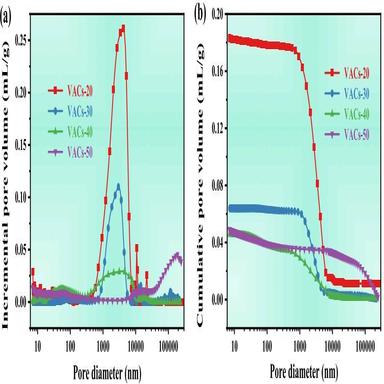
Pore size distribution of VACs specimens: (a) Incremental pore volume; (b) Cumulative pore volume.